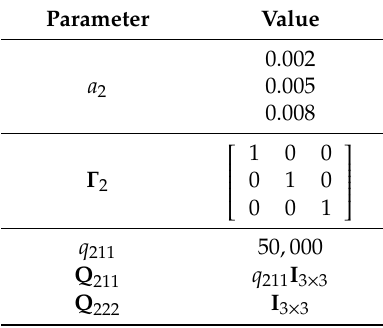
Table 4. Control parameters for optimal control